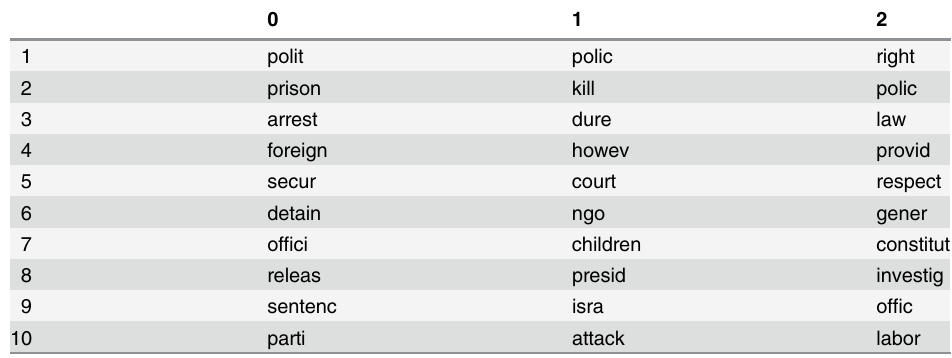
Table 7. Ten most important words for the CIRI Freedom of Assembly and Association variable.